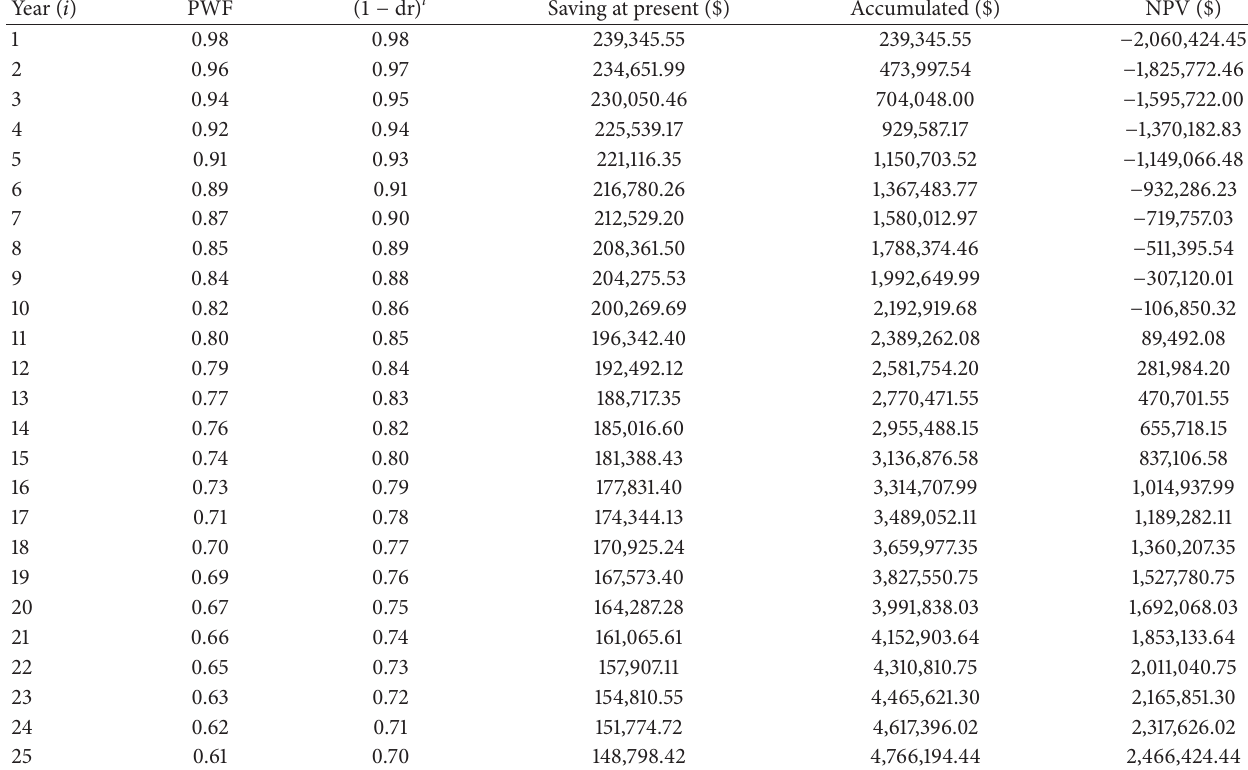
Table 2: Simulation results of